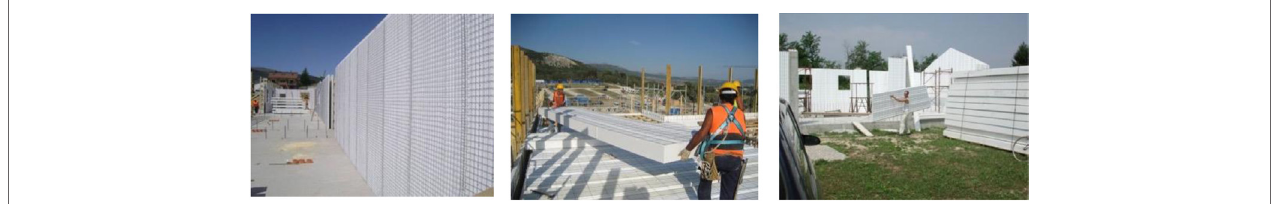
FigURe 9 | Examples of installation of formwork in site (courtesy of Nidyon